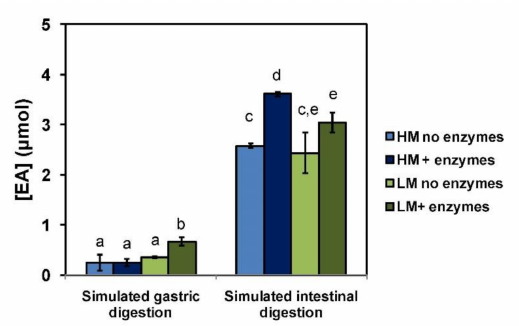
Figure 6. Concentration of EA released under simulated gastrointestinal digestion from pectin films. Reported are the mean ± SD values of three experiments. Different letters indicate statistically significant differences ( p <